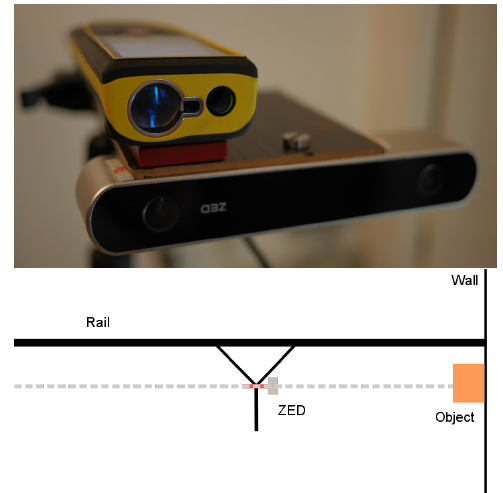
Figure 1. Experimental setup: (Upper image) ZED camera and laser distance meter. (Lower image) The ZED camera is guided along a rail perpendicular to the wall. The camera is aligned with the wall or an object. Images of the scene are taken in equidistant steps Depending on the scene, an additional object was placed in front of the wall. This then counted as a reference point for the distance measurement and reduced the maximum possible dis- tance. Image frames were taken at intervals of 0 . 5 m starting at 1 . 0 m , thus, depending on the scene 6 to 7 images were taken. For the evaluation the disparity maps were generated with all procedures using the rectified images of the ZED camera and then the associated point clouds were generated.